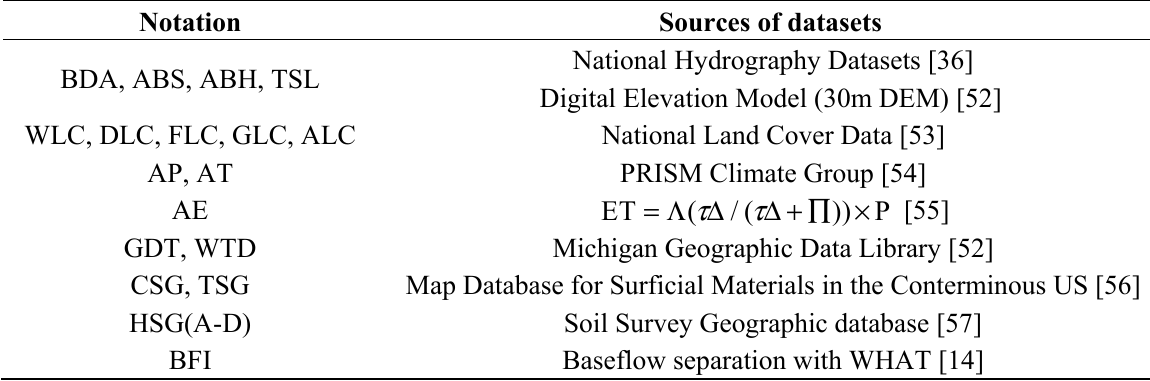
Table 3. Sources of datasets for all watershed characteristics.